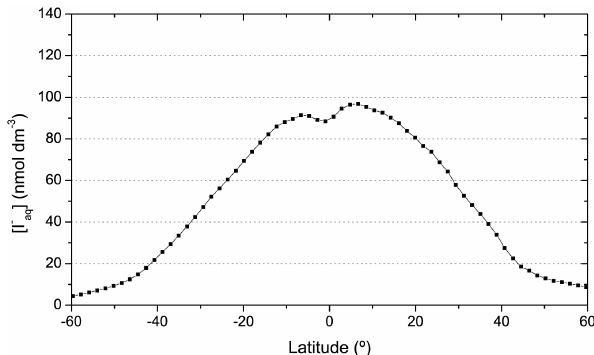
Figure 1. Modelled latitudinal variation of the zonal average sea surface iodide concentration, [I − aq ]. Following Eq. (4), [I − aq ] is mod- elled with CAM-Chem using SST as a proxy. Modelled iodide val- ues fall within the range of [I − aq ] open-ocean measurements reported by Chance et al. (2014), also reproducing the iodide gradient ob- served towards the Equator (see also Ganzeveld et al.,